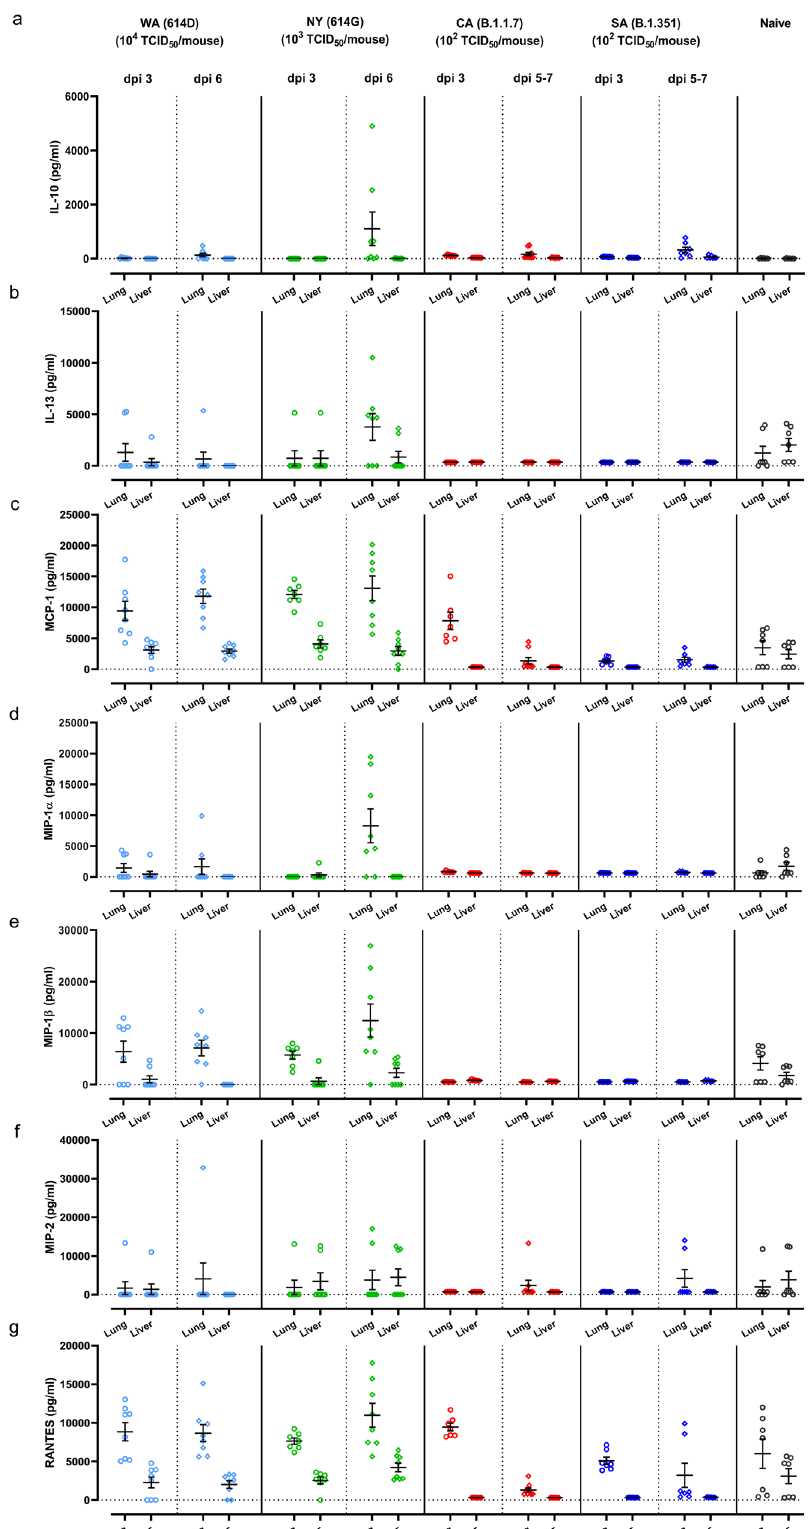
induced by WA (614D) infection 19 . In this study, K18-hACE2 infected with B.1.1.7 and B.1.351 variants exhibited more com- plicated tissue-speci fi c cytokine signatures than those induced by early SARS-CoV-2 strains. Several myeloid cell chemoattractants showed enhanced pulmonary and hepatic secretions in